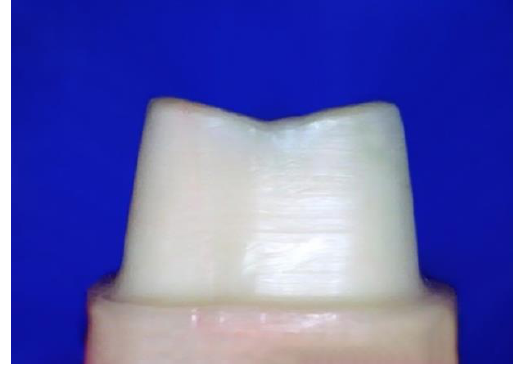
Figure 1: Tooth preparation with modified dental surveyor.